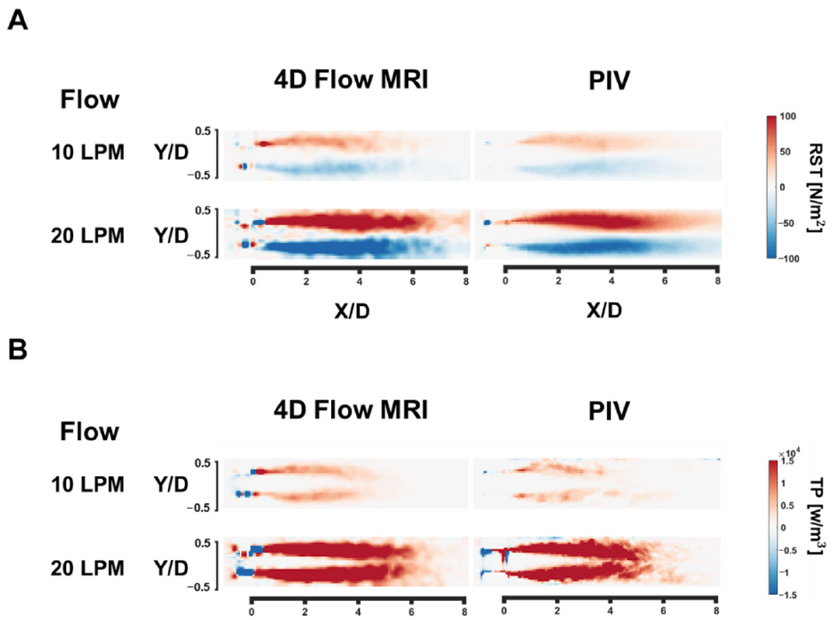
Figure 7. Reynolds stress (RST) and turbulence production (TP) through the stenosis. ( A ) RST contours. ( B ) TP contours.